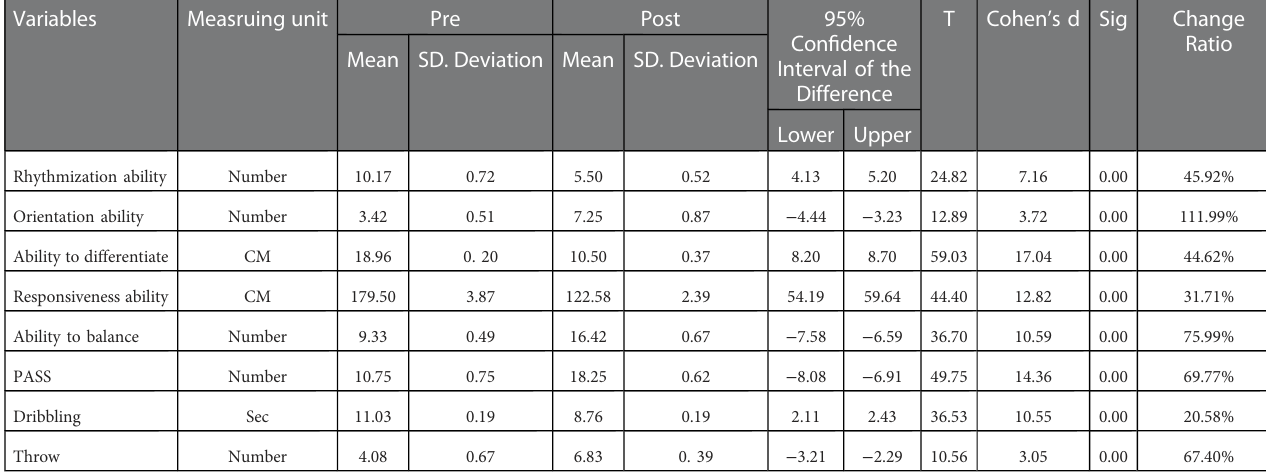
TABLE 3 Indicates the differences between the averages of pre- and post- measurements of the experimental group in the variables under consideration ( n =12). Variables